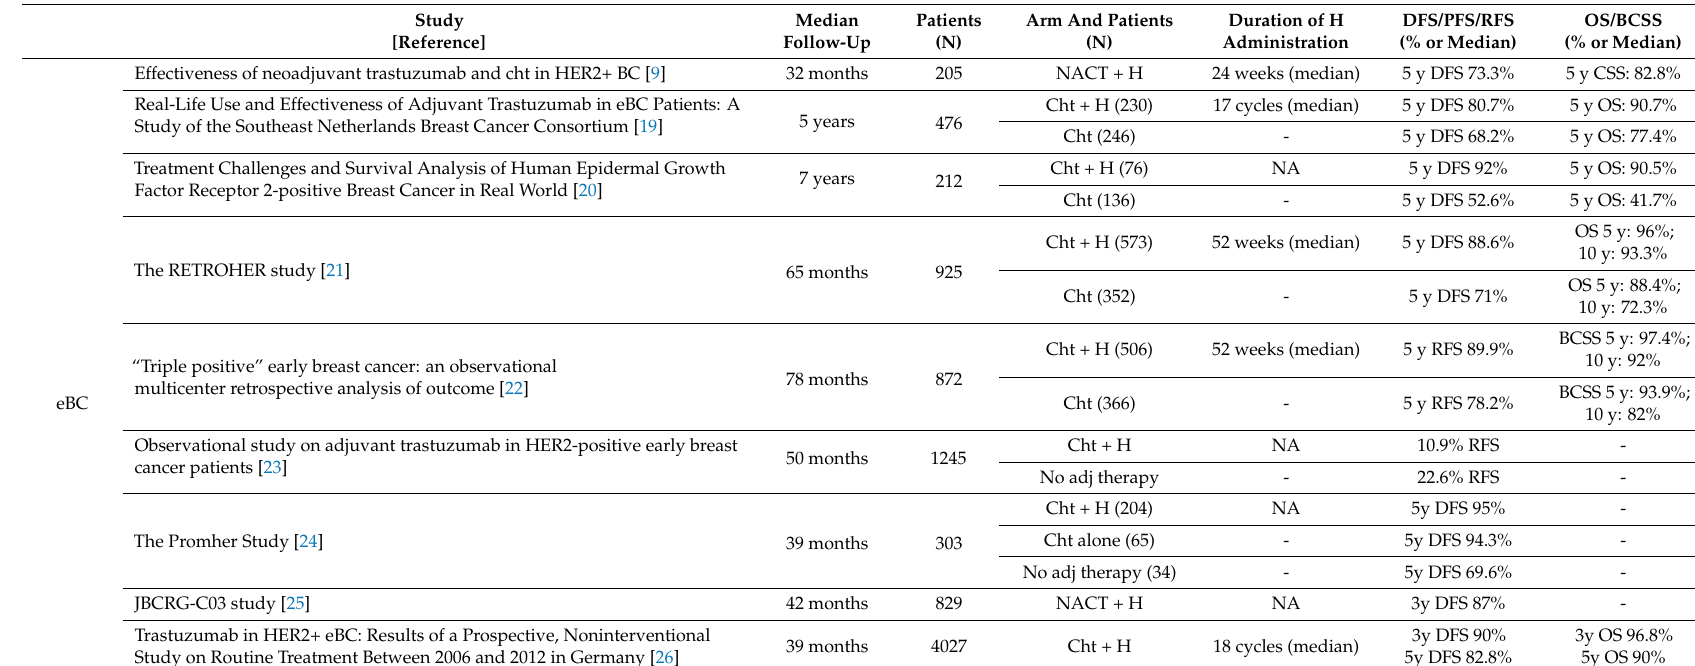
Table 2. Studies included in real world effectiveness